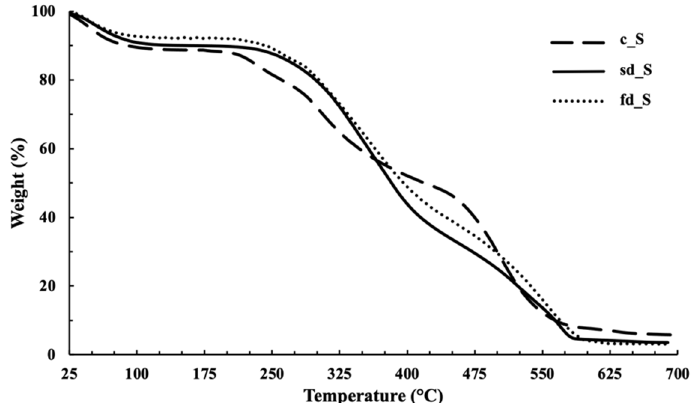
Figure 4. Thermogravimetric curves of the sericin powders.